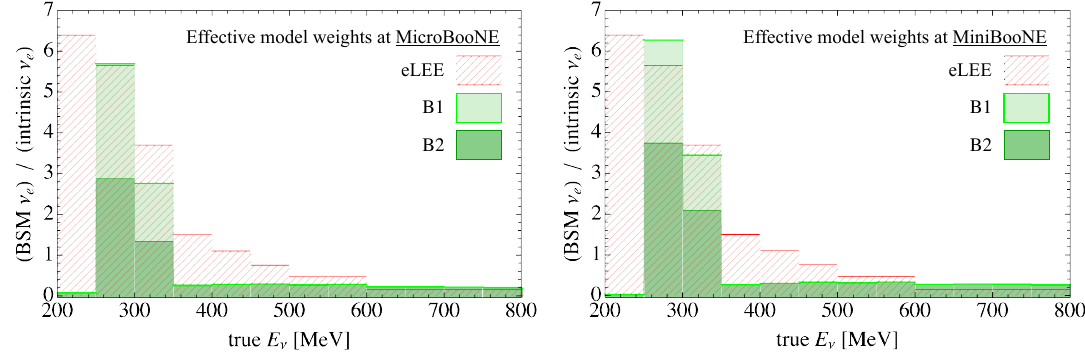
Figure 11 . The effective BSM ν e fluxes at the MicroBooNE (left) and MiniBooNE (right) detectors from the BNB normalized by the expected intrinsic ν background flux in the SM, as predicted e by three different models: the ad hoc empirical LEE model used in the MicroBooNE analyses (red hatched histogram); the quasi-sterile benchmark model B1 defined in (3.22a) and displayed in figure 7 (light green histogram); and the quasi-sterile benchmark model B2 defined in (3.22b) and displayed in figure 8 (dark green histogram). For B1 and B2, the ‘effective’ BSM ν fluxes include e ν µ → ν e oscillations as well as intrinsic ν e